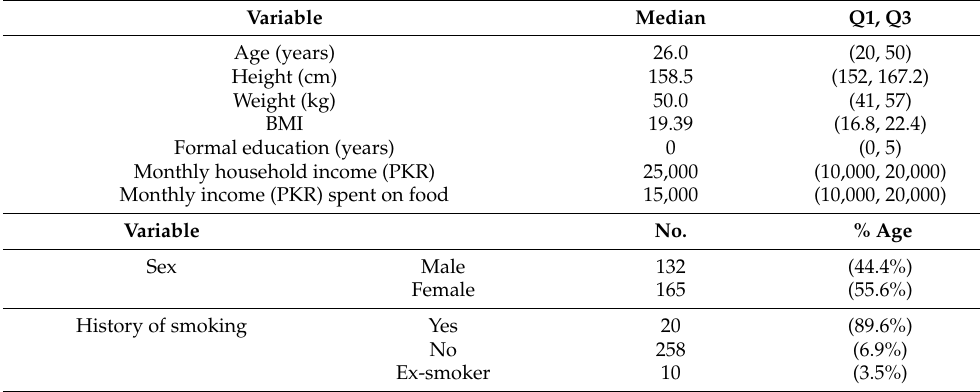
Table 1. Basic demographic and anthropometric characteristics of the participants ( n =